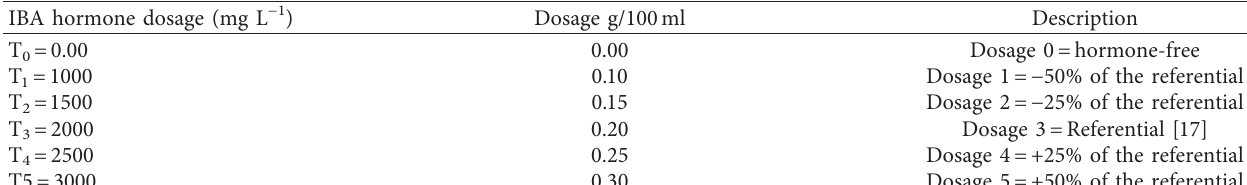
Table 1: Description of treatments.